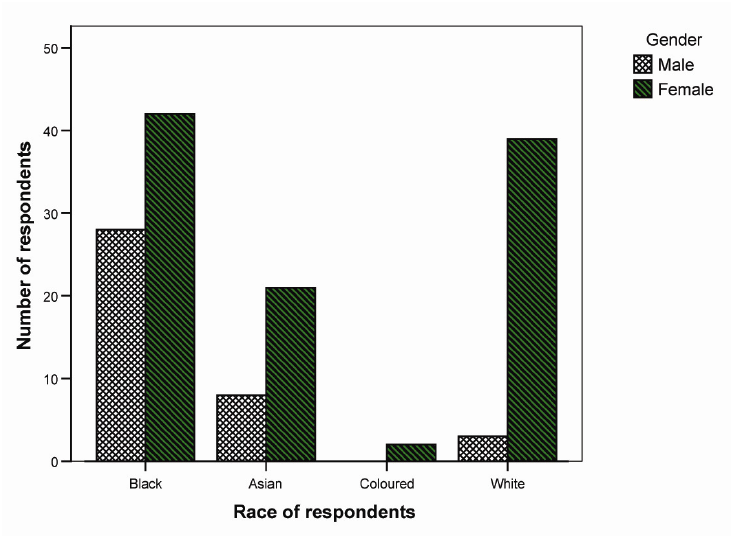
Figure 2: Showing the racial distributions of the respondents. Blacks were more numerous than other racial groups, while coloureds were least